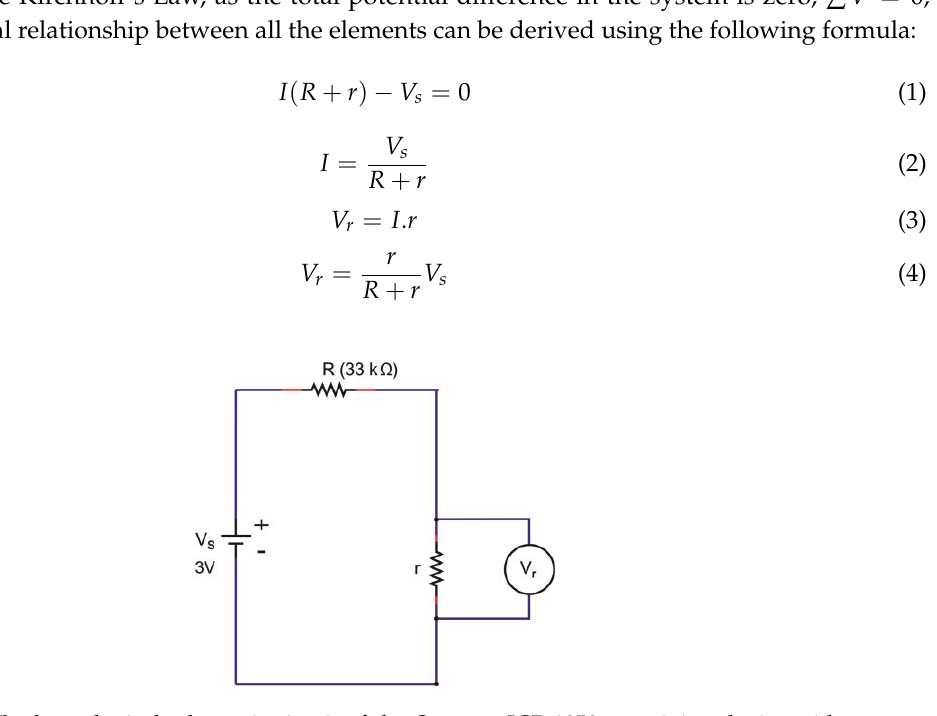
13 of 17 Figure 9. Charge-discharge characteristics of devices of different types of PEDOT:PSS using SS/Ag- PBO electrodes with different polarity of the applied voltage: ( a ) SS(+3 V)/Ag-PBO(0 V) and ( b ) SS(0 V)/Ag-PBO(+3 V). It can be seen from the graphs in Figures 8 and 9 that different PEDOT:PSS polymers showed different charge-discharge profiles, especially for those using Orgacon compared to Ossila and Clevios. In all charge-discharge measurements, regardless of the electrode yarns used and their set of combinations, devices using Orgacon as a solid electrolyte showed zero levels of charge and discharge voltage at all observation times. The discharge profiles from these results are similar to those found in the previous works of Sheila et al. [33]. As discussed earlier, based on our characterization and analysis using NMR and ICP-OES, the Orgacon ICP 1050 was found to be of low resistance and thus, the high conductive type of PEDOT:PSS, which for the most part stems from the lower proportion of PSS in the mixture as compared to Clevios and Ossila. The zero charge-discharge profile of devices having Orgacon PEDOT:PSS, as observed in Figures 8 and 9, suggested the absence of capacitive behavior in the system, which resulted in the